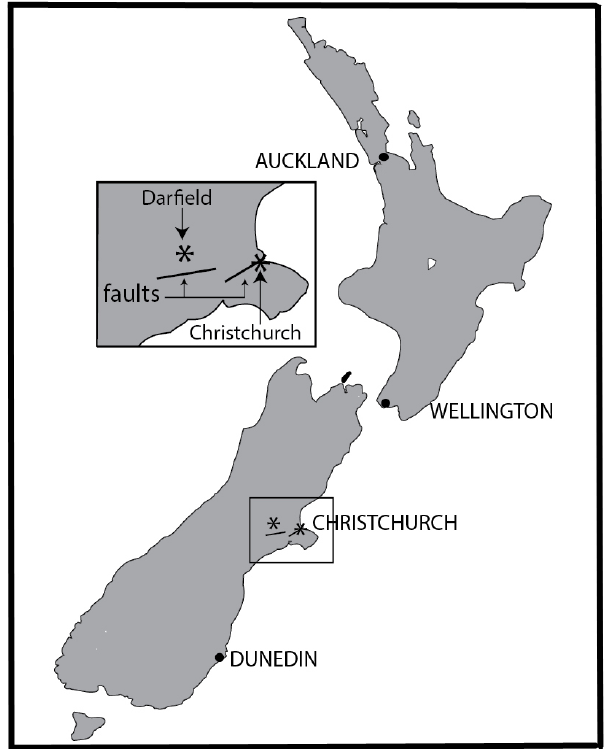
Fig. 1. Location map. Asterisks mark the Darfield (4 Septem- ber 2010) and Christchurch (22 February 2011) earthquake epicen-